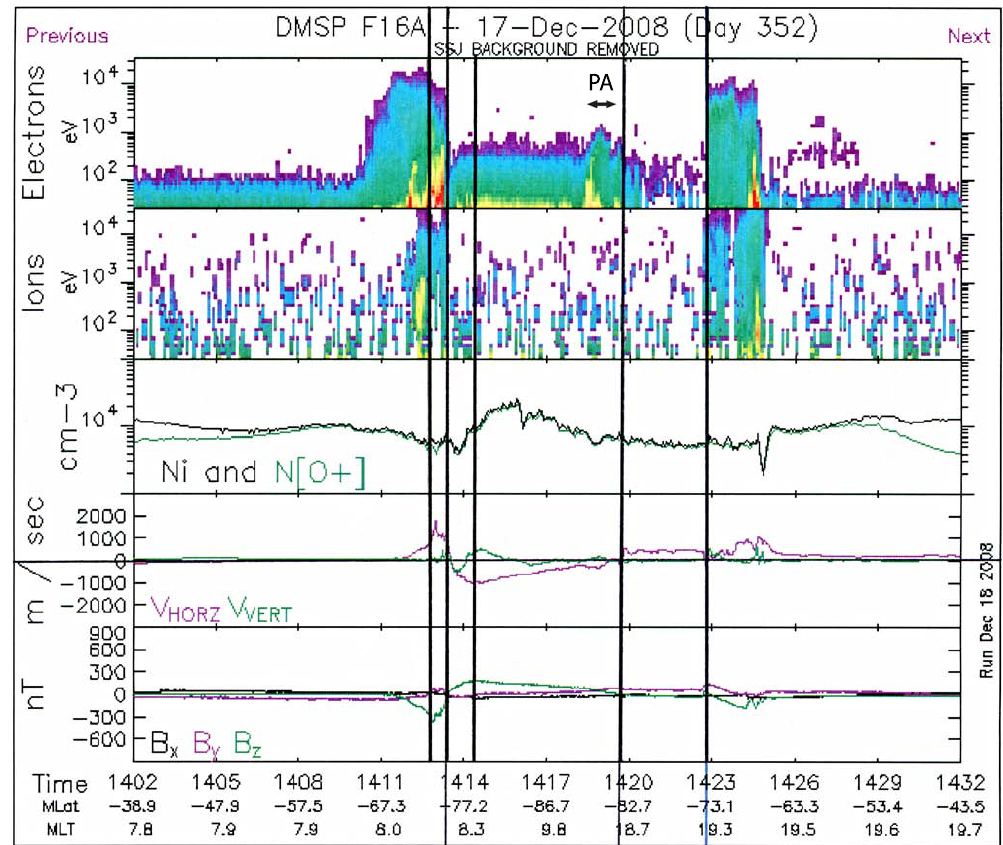
Fig. 5. DMSP F16 data representing the interval 14:02–14:32UT on 17 December 2008. Particle precipitation, ion drift, and magnetic deflections obtained by spacecraft DMSP F 13 during a Southern Hemisphere pass during 13:10–13:40UT on 17 December 2008. Same format as in Fig.